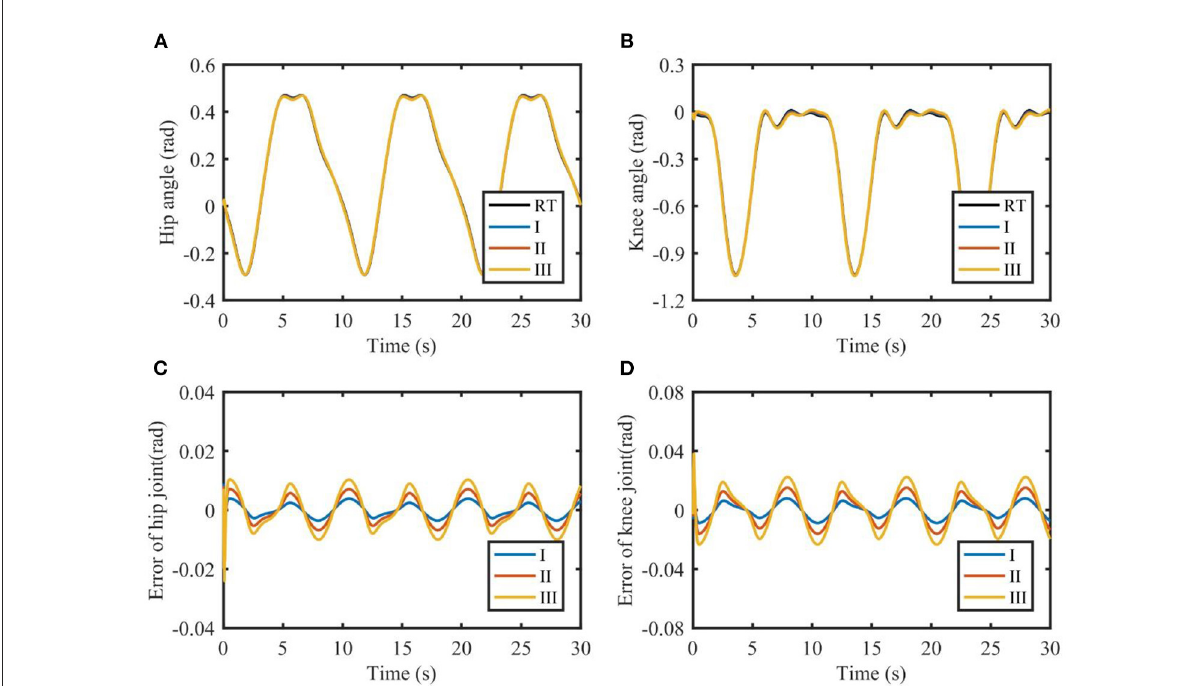
FIGURE4 Tracking performance of TSC-LADRC with different loads. (A,B) are the joint angles of the hip and knee. (C,D) are the tracking errors of the hip and knee. I, II, and III represent three cases of different loads. RT, reference trajectory.